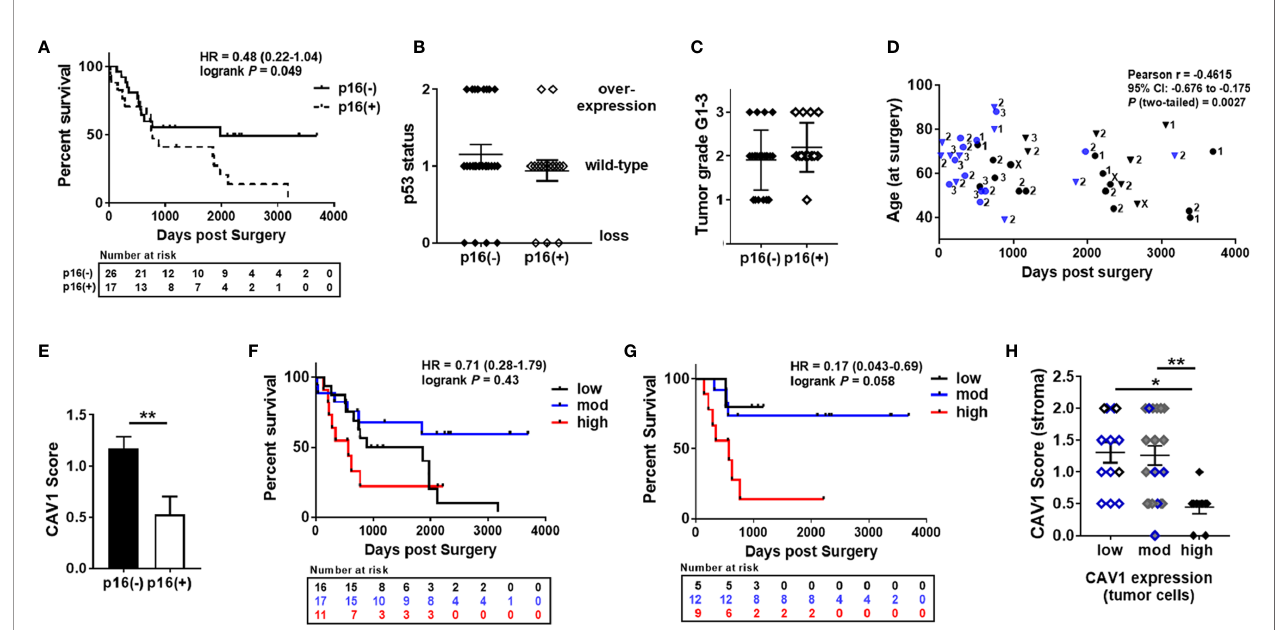
FIGURE 2 | Correlation of epithelial-stromal CAV1 expressions in penile cancer as related to p16 and p53 expressions. (A) Overall survival curves for patients with p16 expressing (n= 17; dashed line) or p16-negative (n=26; black line) tumors. HR, hazard ratio and log-rank P values are indicated. (B) p16 expressing tumors were classi fi ed according to their p53 immunoreactivity (p53 status: overexpression, wild-type, loss). (C) p16 expression in tumors were related to their grade of differentiation: low grade (G1; n= 8), intermediate grade (G2; n=23) and high grade (G3; n=9). (D) Tumor grades (displayed by numbers) were further analyzed according to the respective patient age (at the time of surgery) and the overall survival time (in days) post-surgery. The blue color depicts patient ’ s death. p16- positivity is indicated by rectangles. Pearson correlation coef fi cient (Pearson r), 95% con fi dence interval (CI) and two-tailed P as analyzed for tumor grade versus days post-surgery were indicated (R squared = 0.213). Pearson r = -0.2205 (95%CI: -0.4885 to 0.0855; R squared = 0.049; P = 0.155) for the patients age versus days post-surgery (GX; n=3: The tumor grade could not be identi fi ed.) (E) p16 expressing tumors were classi fi ed according to their CAV1 immunoreactivity score for low (0-0.5), moderate (>0.5-1.5), and high (>1.5-2) CAV1 expression levels within the tumor epithelium. **P < 0.01 by unpaired t-test (two-tailed). (F) Overall survival curves for patients with low (n=17), moderate (n=15) and high (n=11) CAV1 expressions in tumor cells. HR, hazard ratio and log-rank P (low versus high CAV1 levels) are indicated. HR=0.36 (0.12-1.11), log-rank P (Mantel-Cox) =0.047 (moderate vs. high CAV1). (G) Overall survival curves for patients with p16-negative tumors and low (n=8), moderate (n= 6) and high (n=12) CAV1 content within tumor cells. HR and log-rank P (low versus high CAV1 levels) are indicated. HR=0.22